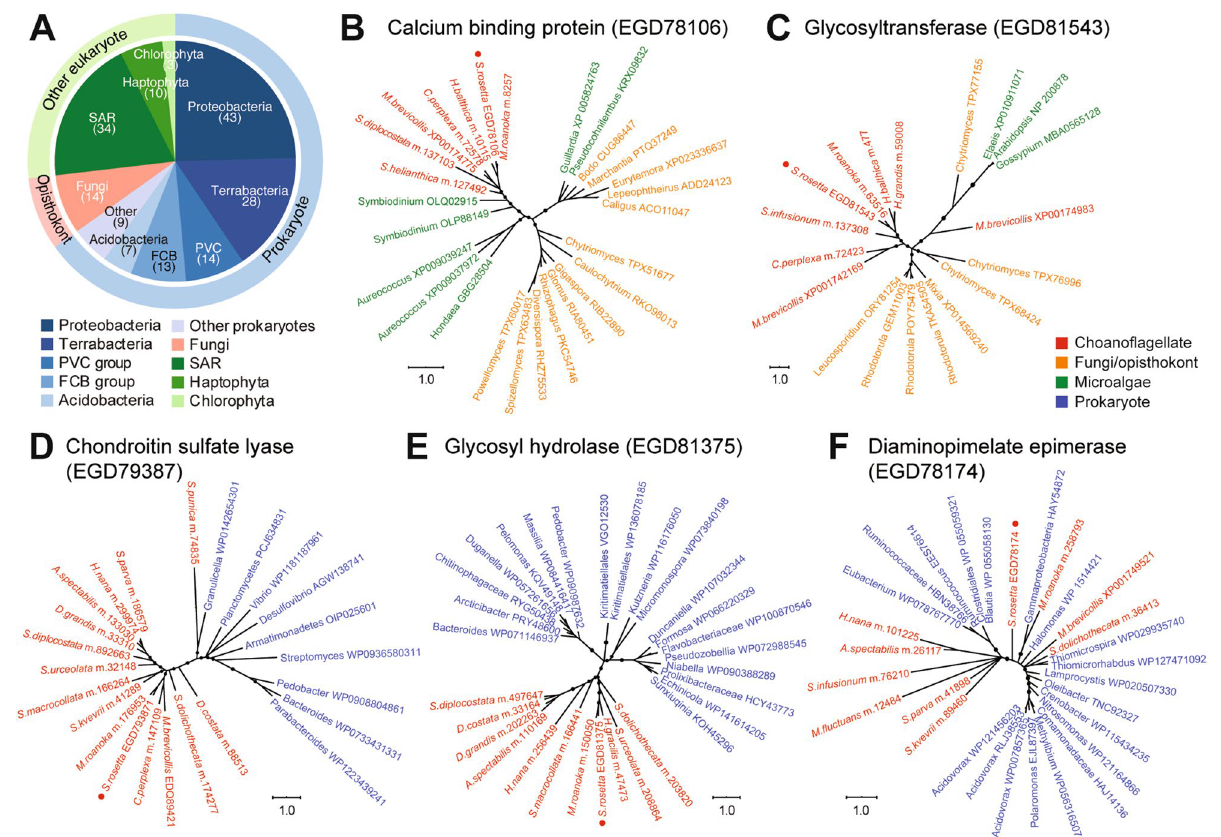
Figure 3. Potential donor phyla of candidate HGTs in S. rosetta . ( A ) Taxon affiliation of candidate HGTs based on the best sequence match for each gene. Phylogenetic analysis of selected candidate HGTs, including ( B ) calcium binding protein of microalgal origin, ( C ) glycosyltransferase of fungal origin, and ( D ) chondroitin sulfate lyase, ( E ) glycosyl hydrolase, and ( F ) diaminopimelate epimerase of prokaryotic origin. Genes from choanoflagellates are shown in red, fungi or opisthokonts in orange, microalgae in green, and prokaryotes in blue. S. rosetta genes are indicated by a red dot. Trees were generated using MrBayes 3.2.6. Circles at the branches indicate posterior probabilities of